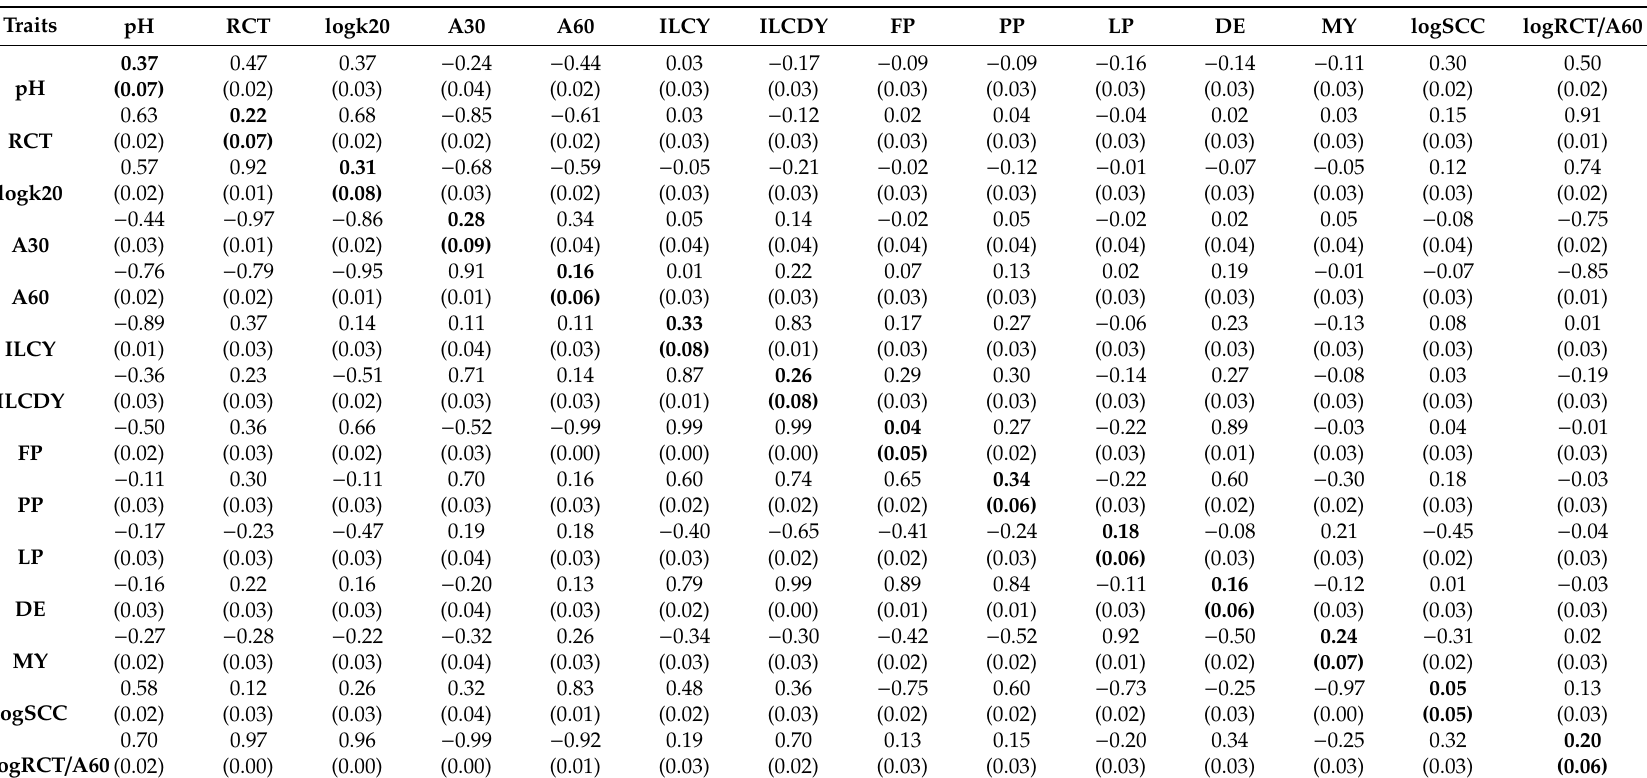
Table 4. Estimates of heritability ( diagonal in bold font ), phenotypic correlations (above the diagonal) and genomic (below the diagonal) correlations between the milk and cheese-making